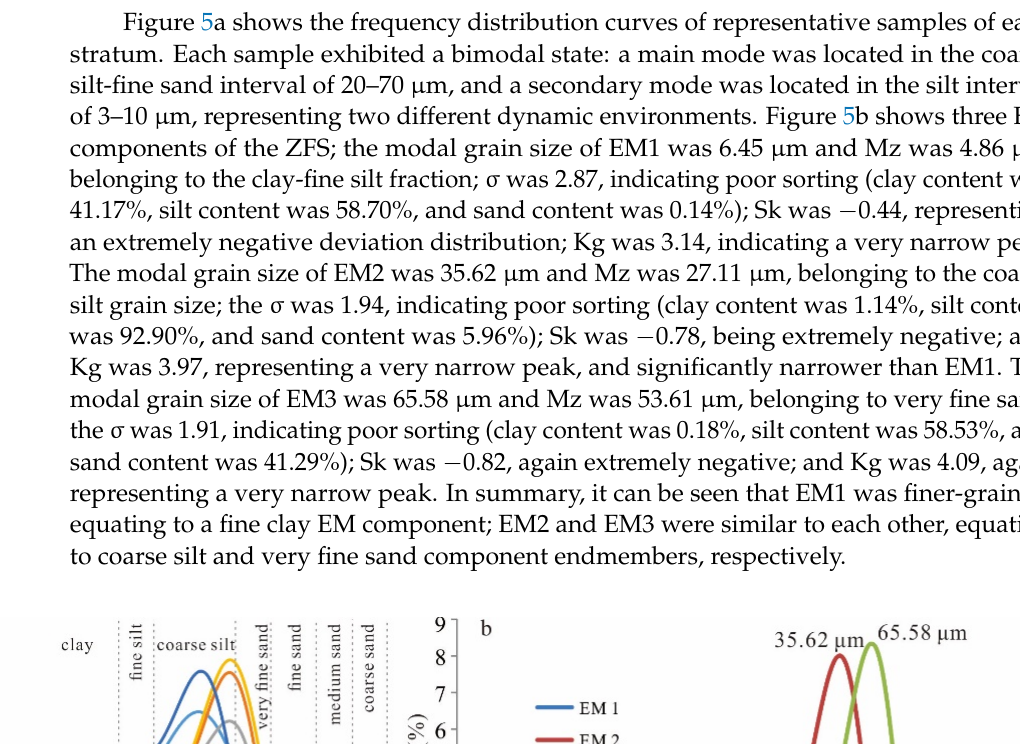
Figure 4. Relationships among linear correlation, angular deviation, and endmember numbers in the grain size EM analysis of the ZFS. grain size EM analysis of the ZFS.